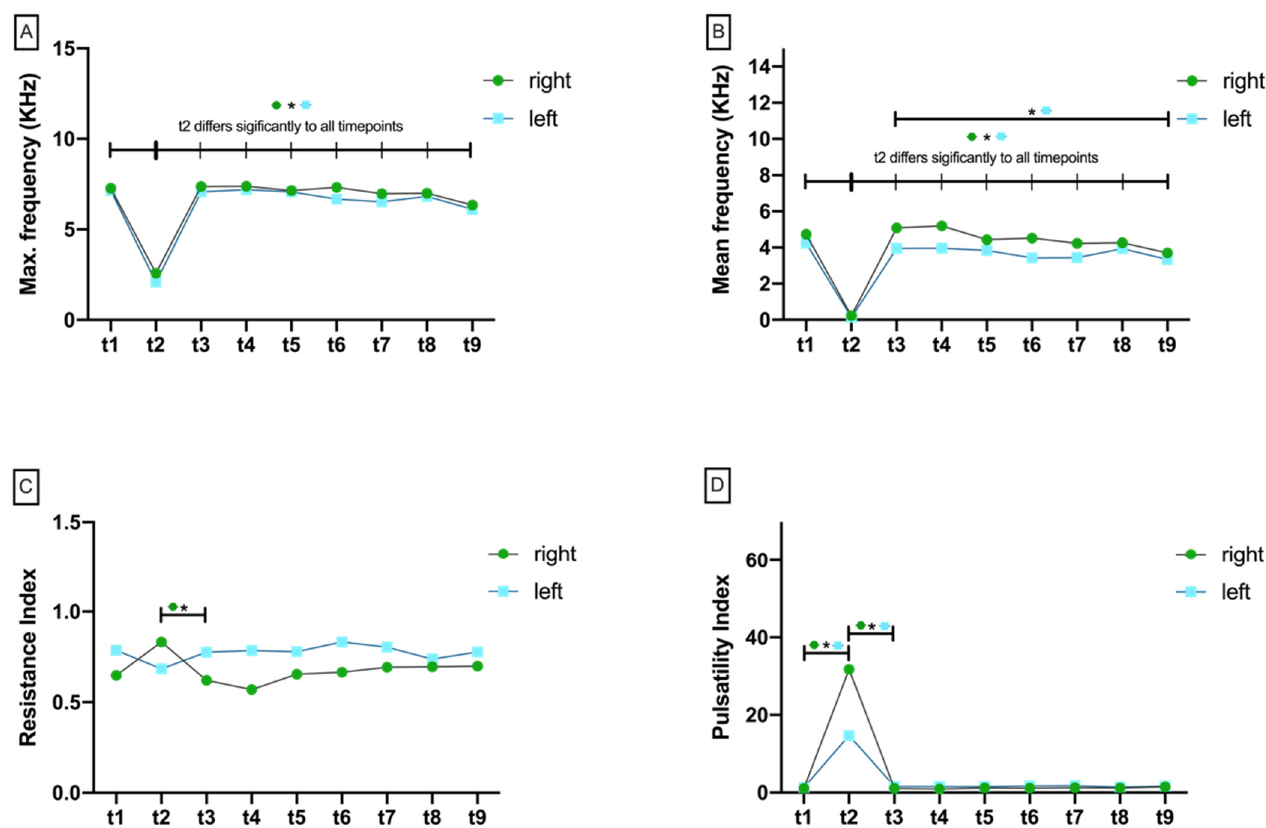
Figure 6. Aligned dotplot show doppler characteristics at different measurement timepoints (t1–t9). ( A ) Maximum frequency in KHz (Max.KHz), ( B ) Mean frequency in KHz (Mean.KHz), ( C ) resistance index (RI), and ( D ) pulsatility index (PI). Crossbars with asterisks mark significant differences.